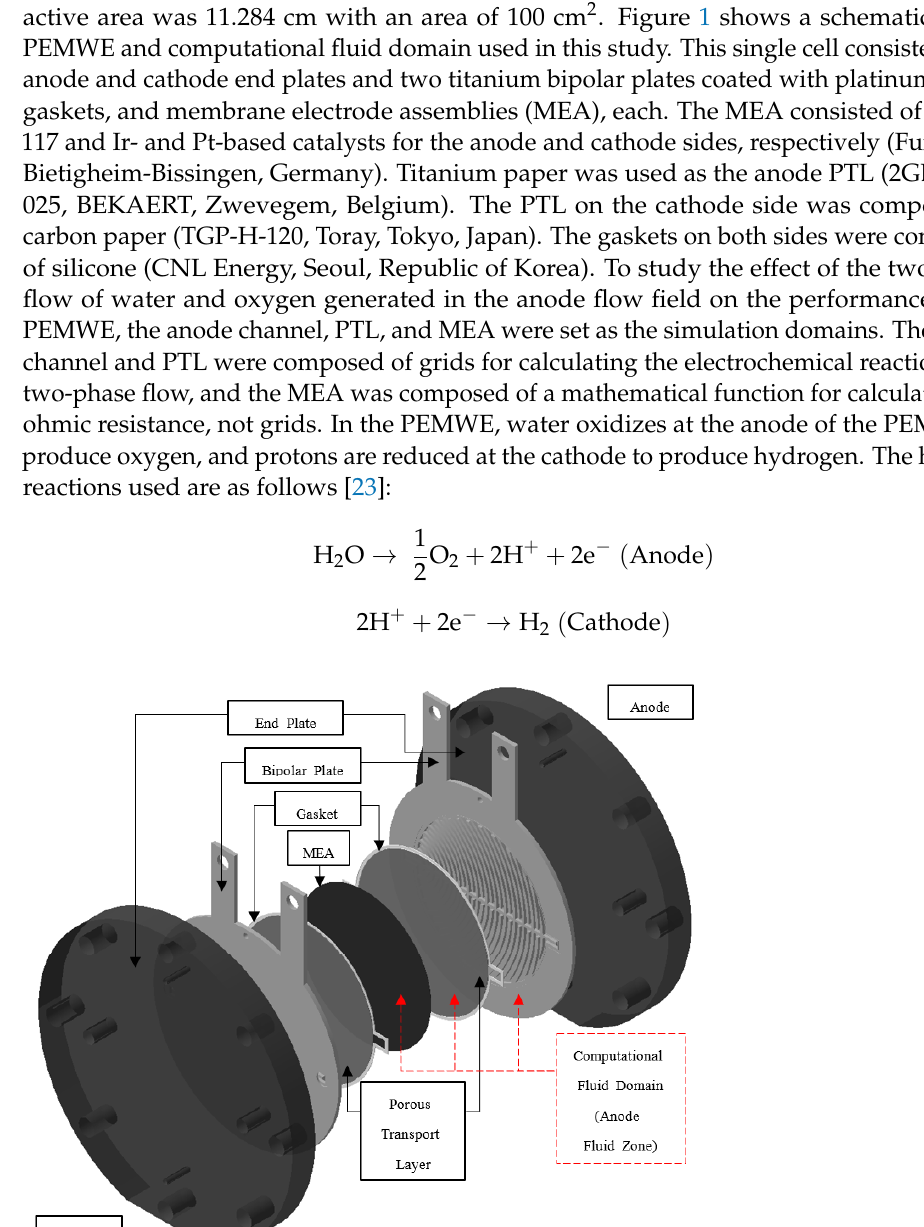
( b ) Figure 2. Schematic of ( a ) the computational fluid domain and ( b ) channel and PTL flow fields in the anode side of PEMWE.